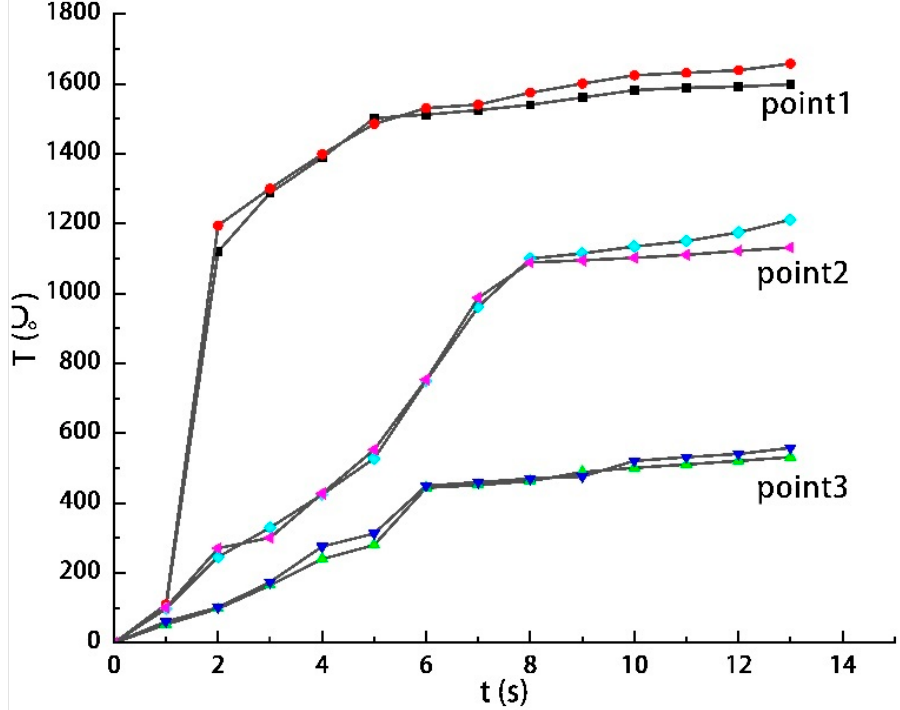
Figure 12. Simulation and test results of the temperature rise curve.